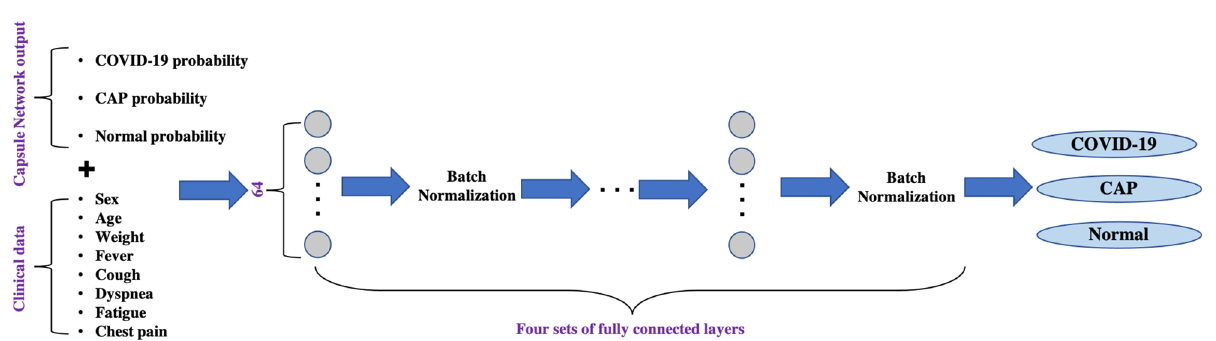
Figure 2. The MLP model combining the output of the two-stage deep learning model with the clinical data. Clinical data includes demographic characteristics and 5 common COVID-19 and CAP symptoms. Four sets of fully connected layers determine the final output.